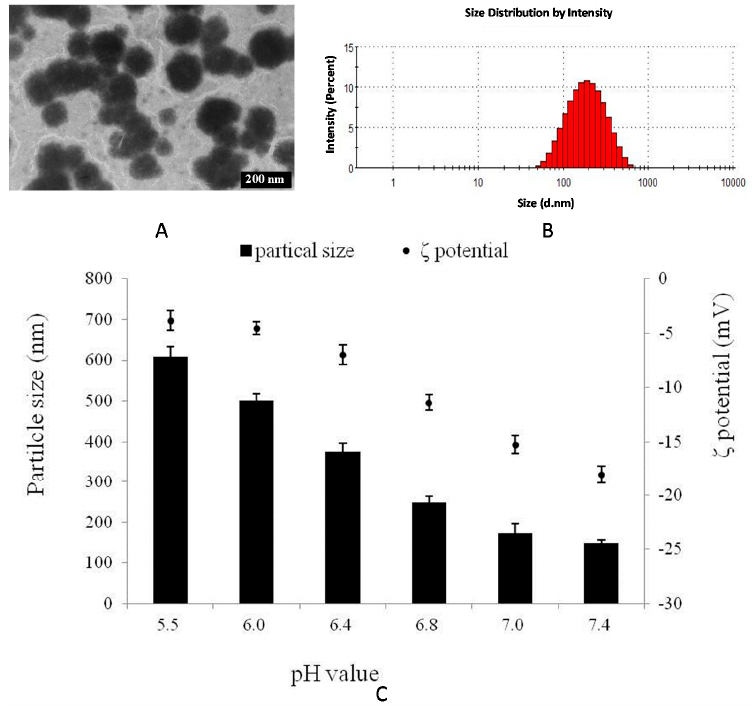
Figure 4. Characterization of HA–GA/HA–His mixed micelles. ( A ) TEM image of mixed micelles; ( B ) Particle size distribution of mixed micelles; ( C ) Particle size and ζ potential of mixed micelles at external pH 7.4–5.5.